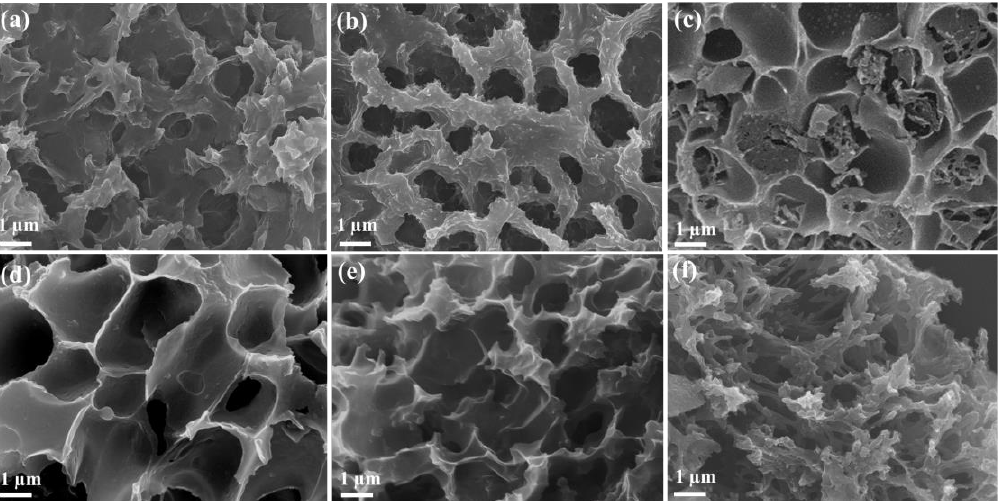
Figure 1. SEM images of the activated lotus leaf at different calcination conditions ( a ) 400 °C, ( b ) 600 °C, ( c ) 800 °C under 50 mL min −1 of N 2 ; 100 mL min −1 ( d ), 150 mL min −1 ( e ), and 200 mL min −1 ( f ) of N 2 at 800 °C.